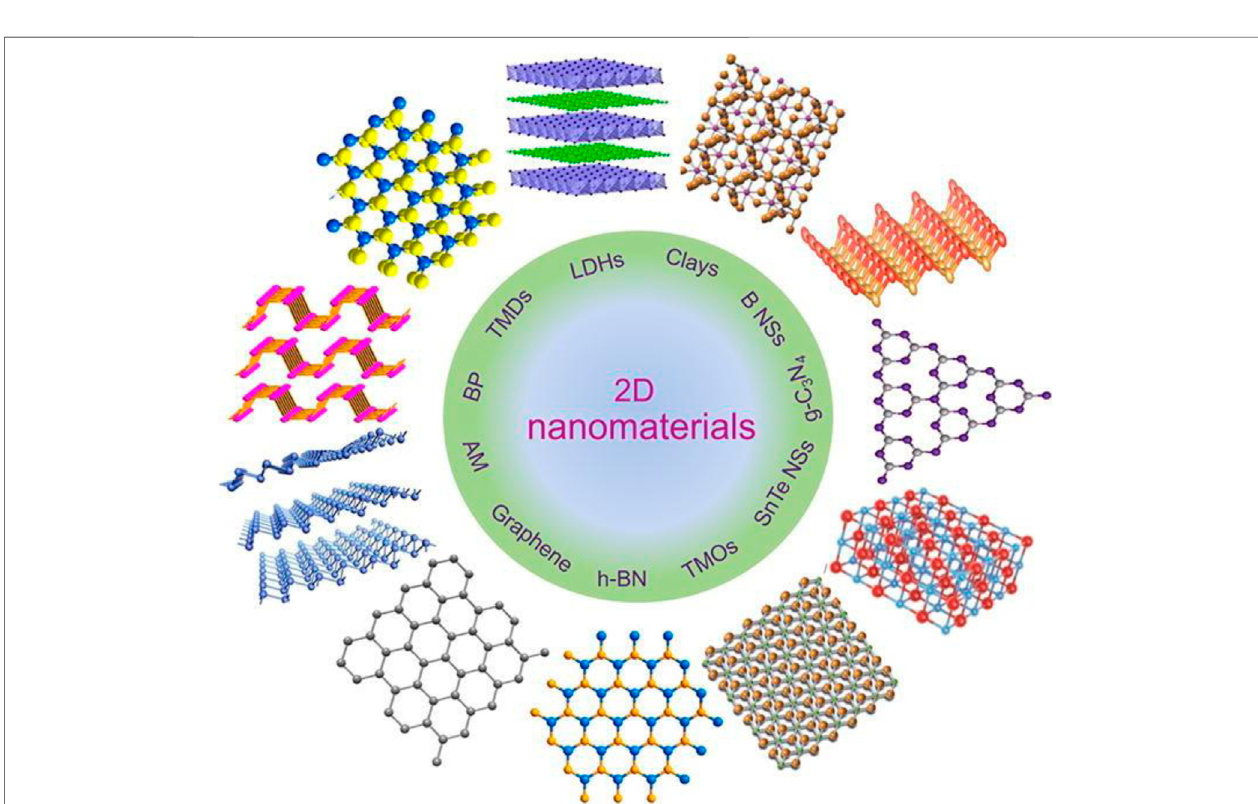
FIGURE 1 | Structures of 2D nanomaterials. Reproduced with permission (T. Hu et al., 2019) (Copyright 2019 ELSEVIER).